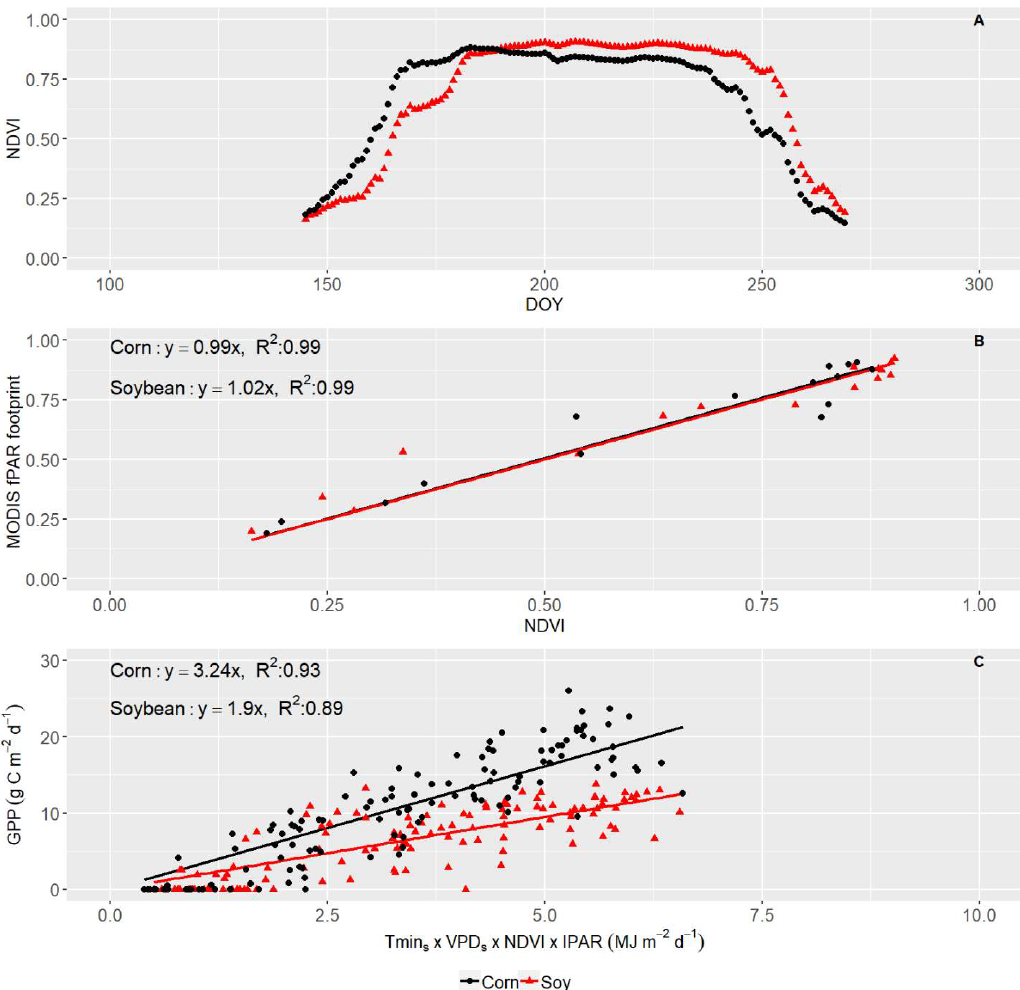
Figure 3. Measurements on the corn (black circles) and soybean (red triangles) field in Story County during the 2016 growing season ; ( A ) measured and interpolated corn and soybean NDVI near the eddy-flux stations; ( B ) linear regression analysis (p < 0.05) with measured NDVI as independent and MODIS fPAR in the 90% footprint area as dependent variable; ( C ) linear regression analysis (p < 0.05) with the product of the Tmin s , VPD s , NDVI, and IPAR (MJ m − 2 d − 1 ) as independent and GPP (g C m − 2 d − 1 ) as dependent variable with the slope being RUE max . R 2 : coe ffi cient of determination, Tmin s : temperature scalar, VPD s : vapor pressure deficit scalar, IPAR: incoming photosynthetic active radiation, GPP: gross primary production, RUE max : maximum radiation use e ffi